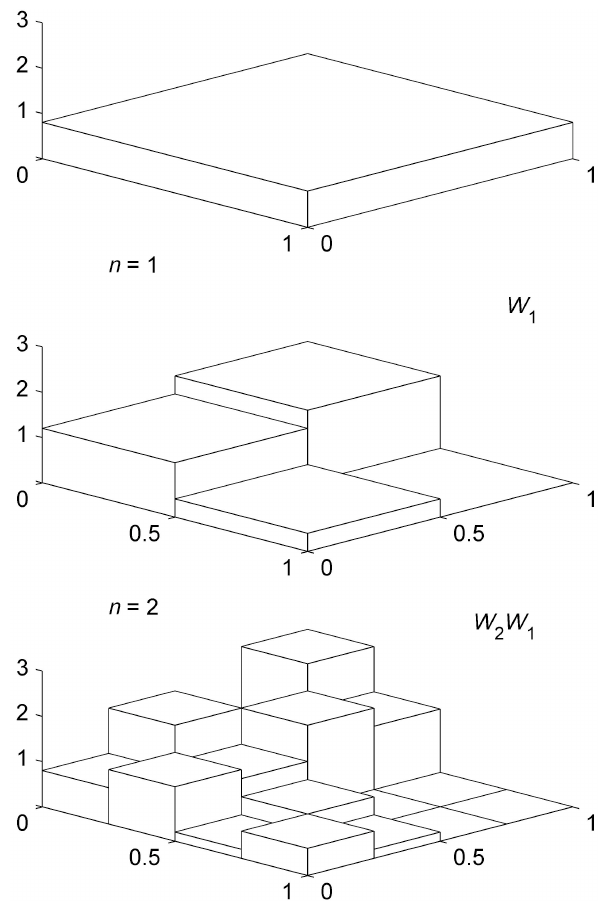
Fig. 2. Schematic of two-dimensional multiplicative cascade with branching number b